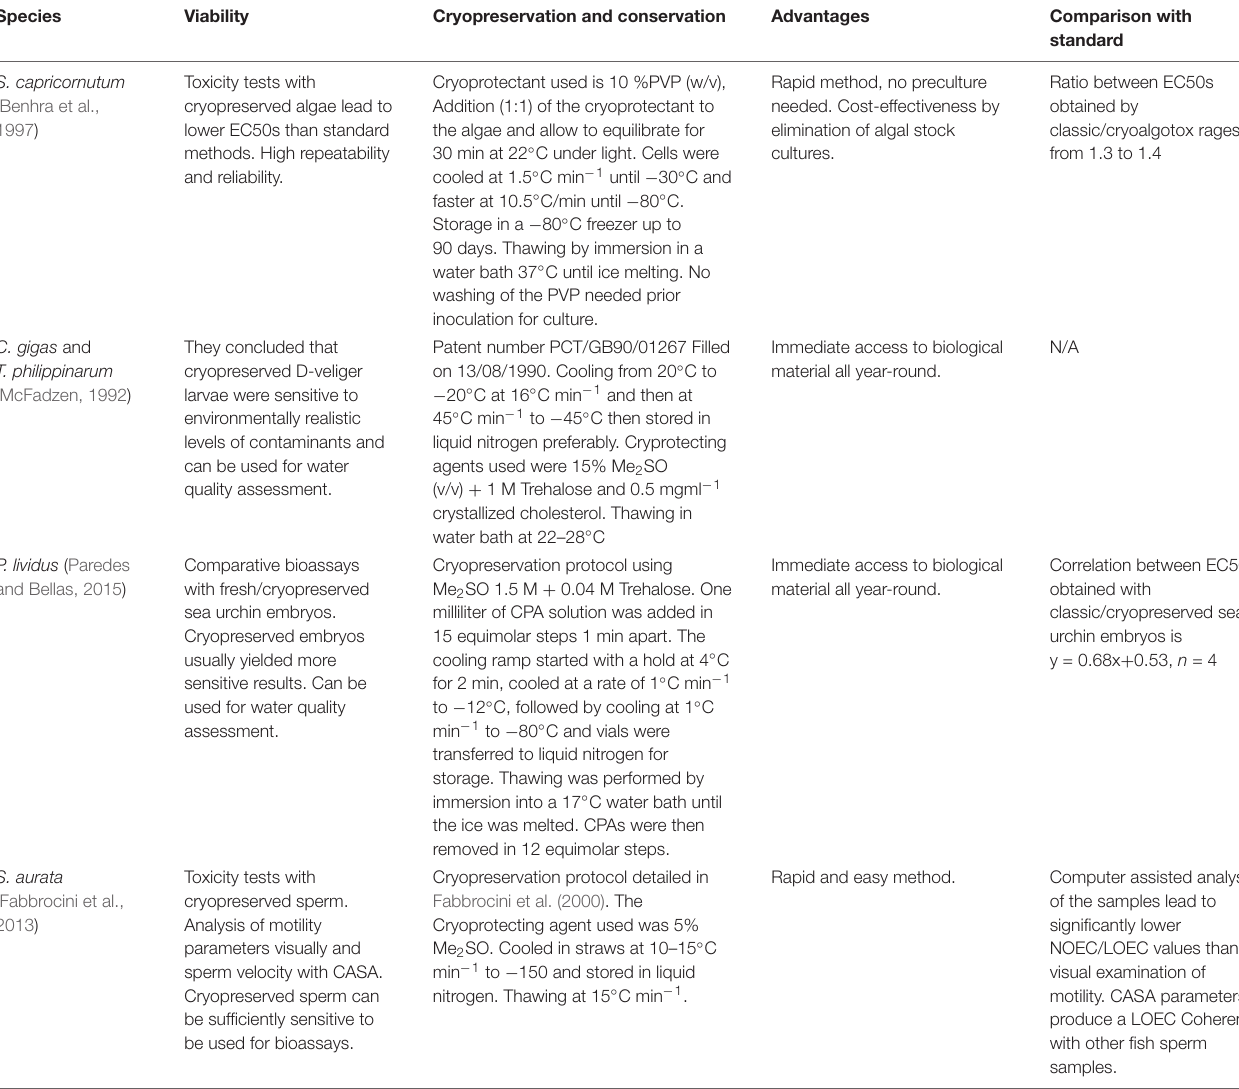
TABLE 1 | Cryopreserved marine organisms that had been used as an alternative to fresh standard methods for evaluating marine water